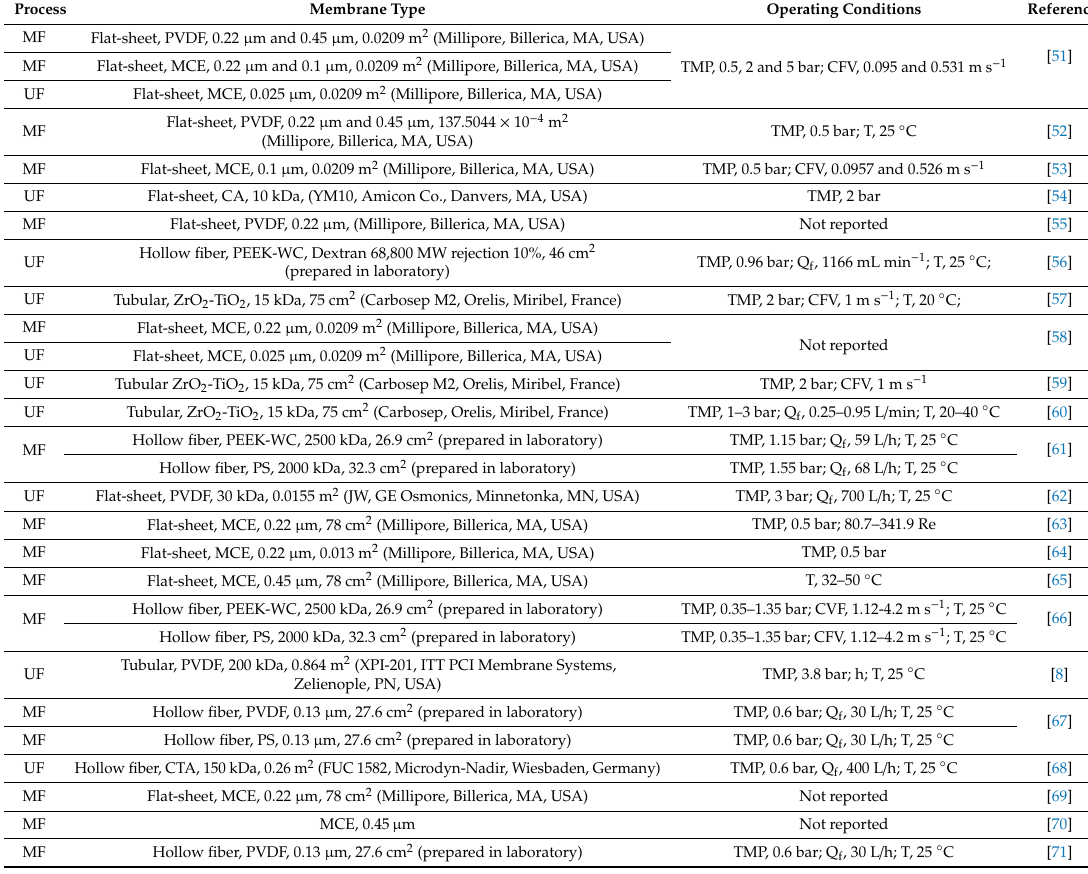
Table 2. Pomegranate juice clarification by MF and UF